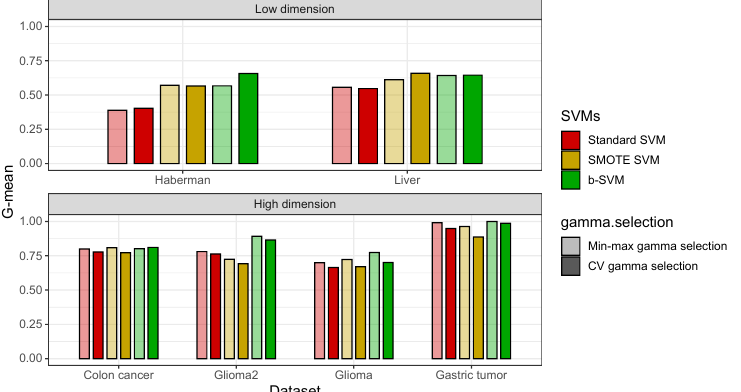
Figure 6. Classification performance (G-mean) of SVMs using different gamma selections in real